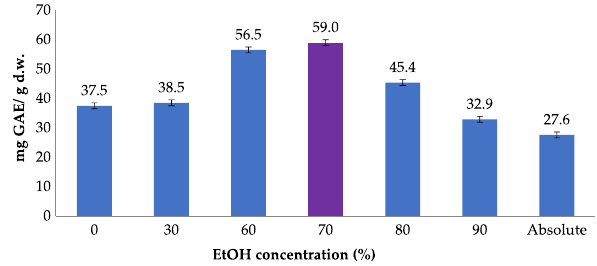
Figure 1: Polyphenol extraction a ff ected by ethanol concentration